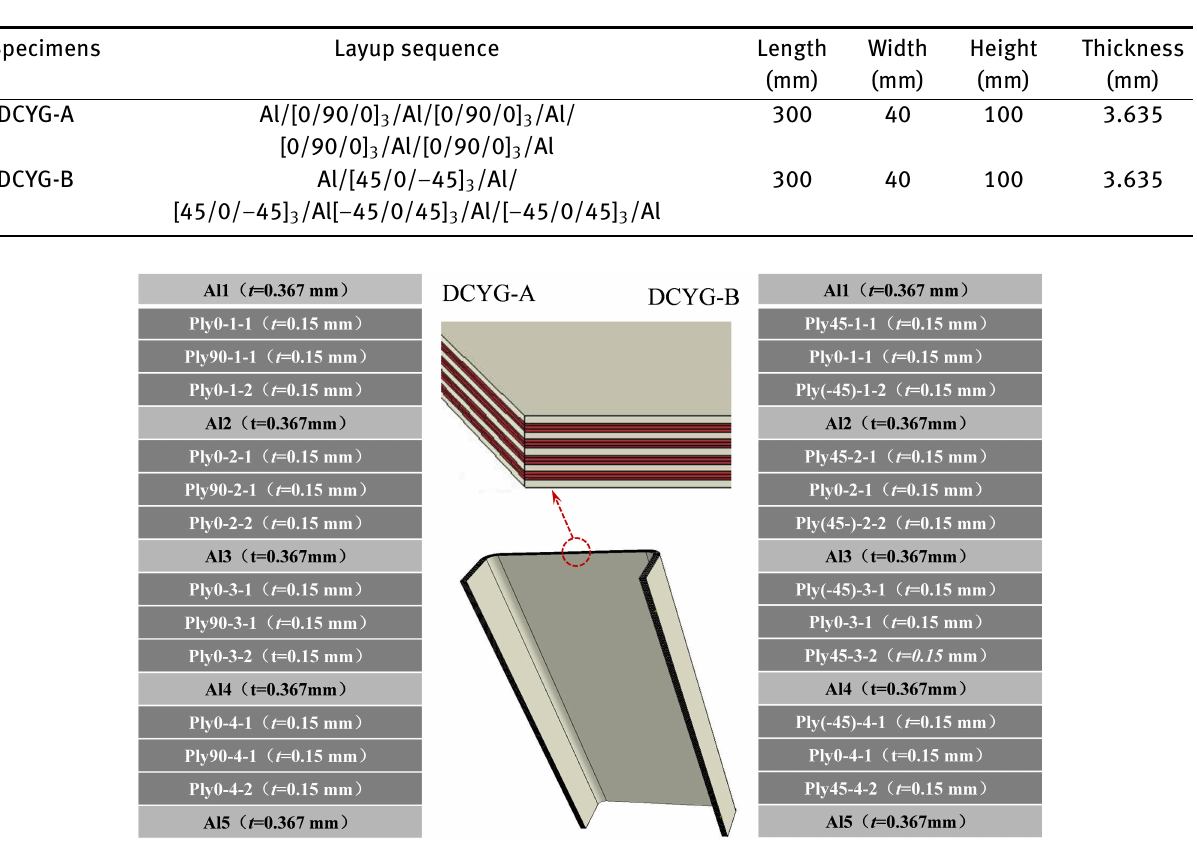
Table 1: Specimen notations, layup sequence, and dimensions of fiber and metal laminates.